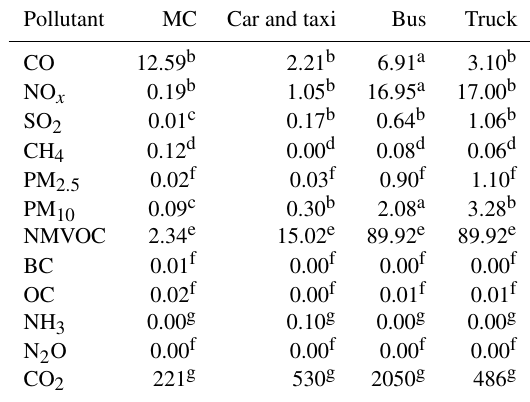
Table 3. Average daily vehicle kilometers traveled of vehicle types in HCMC (Oanh and Van, 2015).